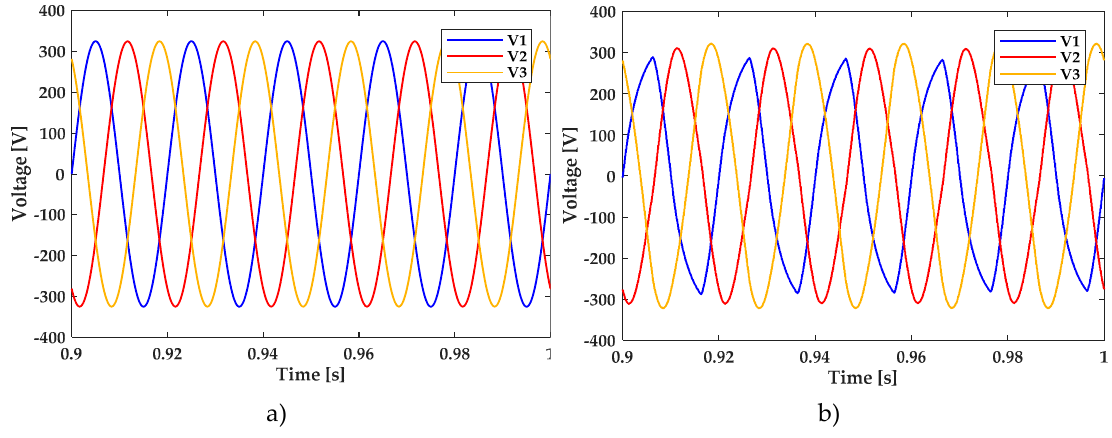
Figure 13. Three-phase voltage waves for: ( a ) U DCbus,ref = 1200 V; ( b ) U DCbus,ref = 900 V.